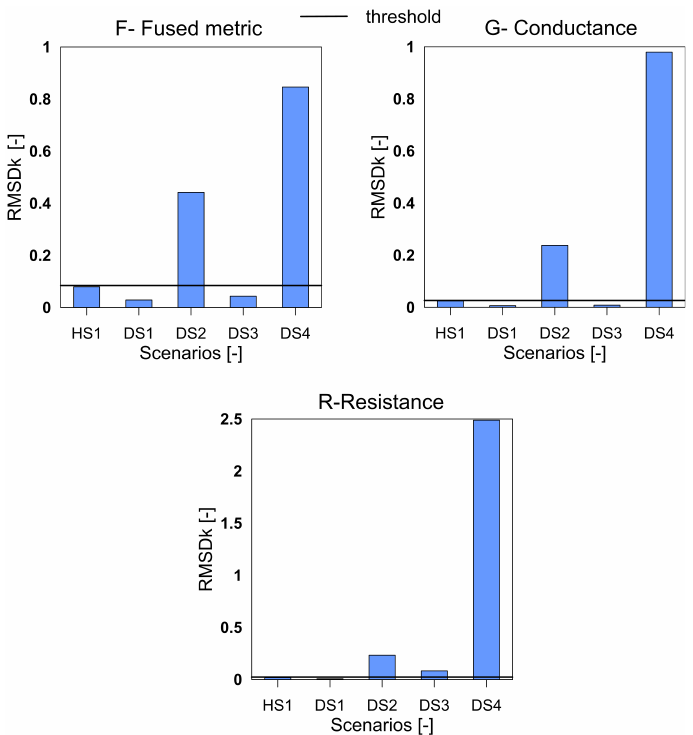
Figure 13. The RMSDk index for the variables F, G and R for GFRP plate.